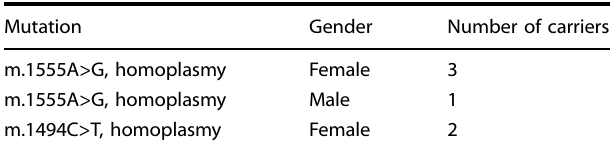
Table 3. Six carriers of MT-RNR1